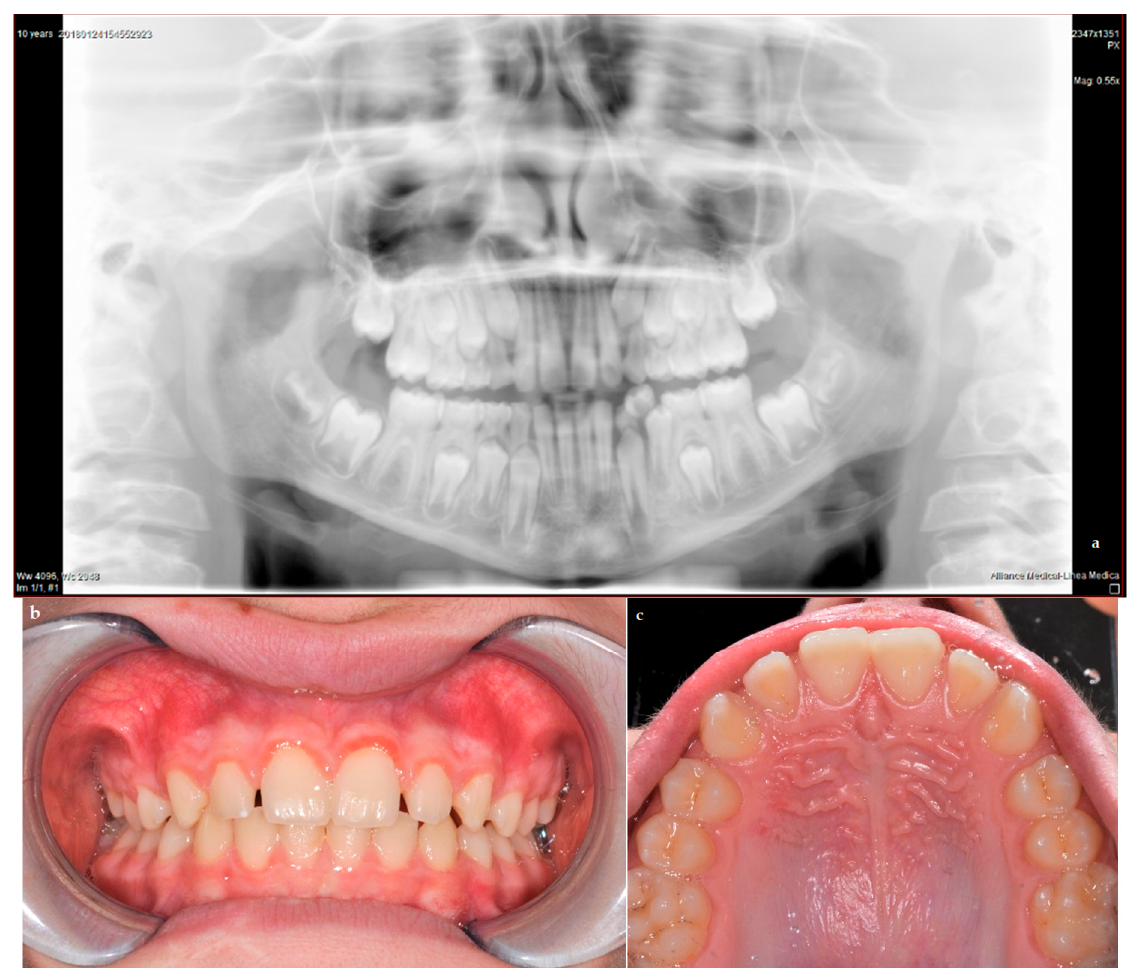
Figure 4. Panoramic view ( a ) shows normal development of the permanent successor at age 10; clinical pictures ( b , c ) show successful follow-up at age 12.